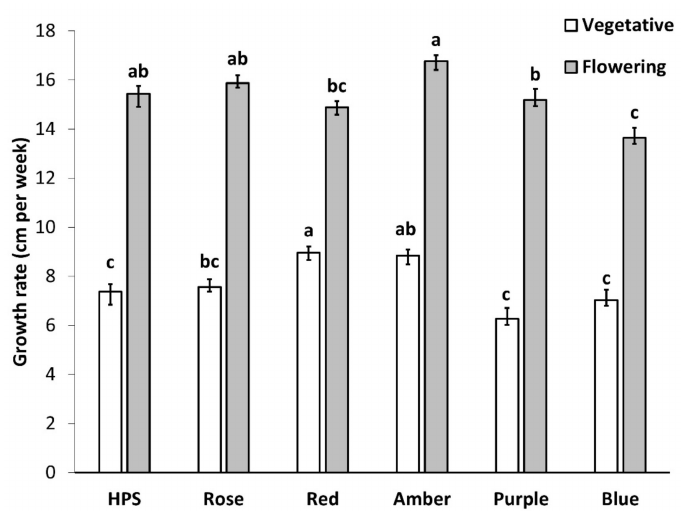
Figure 2. Effect of light spectra on the vertical growth rate of C. sativa during the vegetative phase (white) and the first three weeks of the flowering phase (grey) in the ‘Babbas Erkle Cookie’ accession. The results are mean and SE ( n = 9). Different letters (a, b, c) above the bars represent a significant difference between treatments by Tukey HSD ( p < 0.05). Treatments are high-pressure sodium (HPS), Blue (430 nm), Red (630 nm), Rose (430 + 630 nm, B:R ratio 1:10), Purple (430 + 630 nm, B:R ratio 2:1), and Amber (595